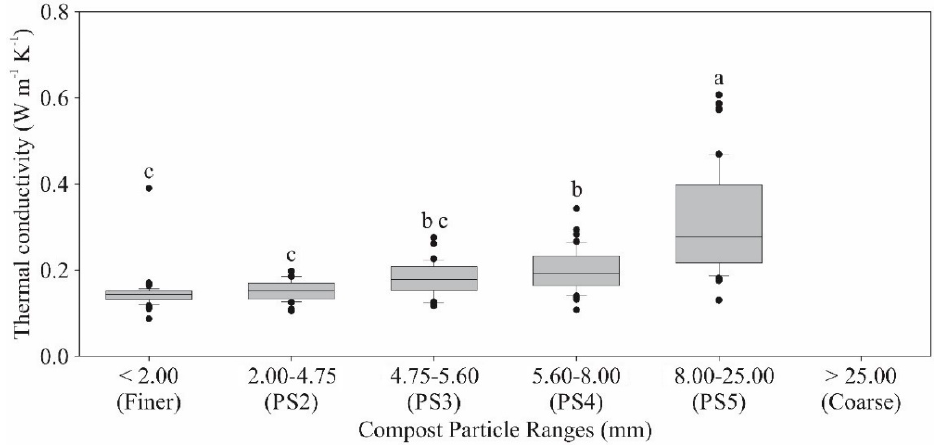
Figure 9. Variation in thermal conductivity (W m − 1 K − 1 ) and compost particle ranges (mm) for bedding materials. Values followed by different letters are significantly different ( p < 0.05; Tukey test).